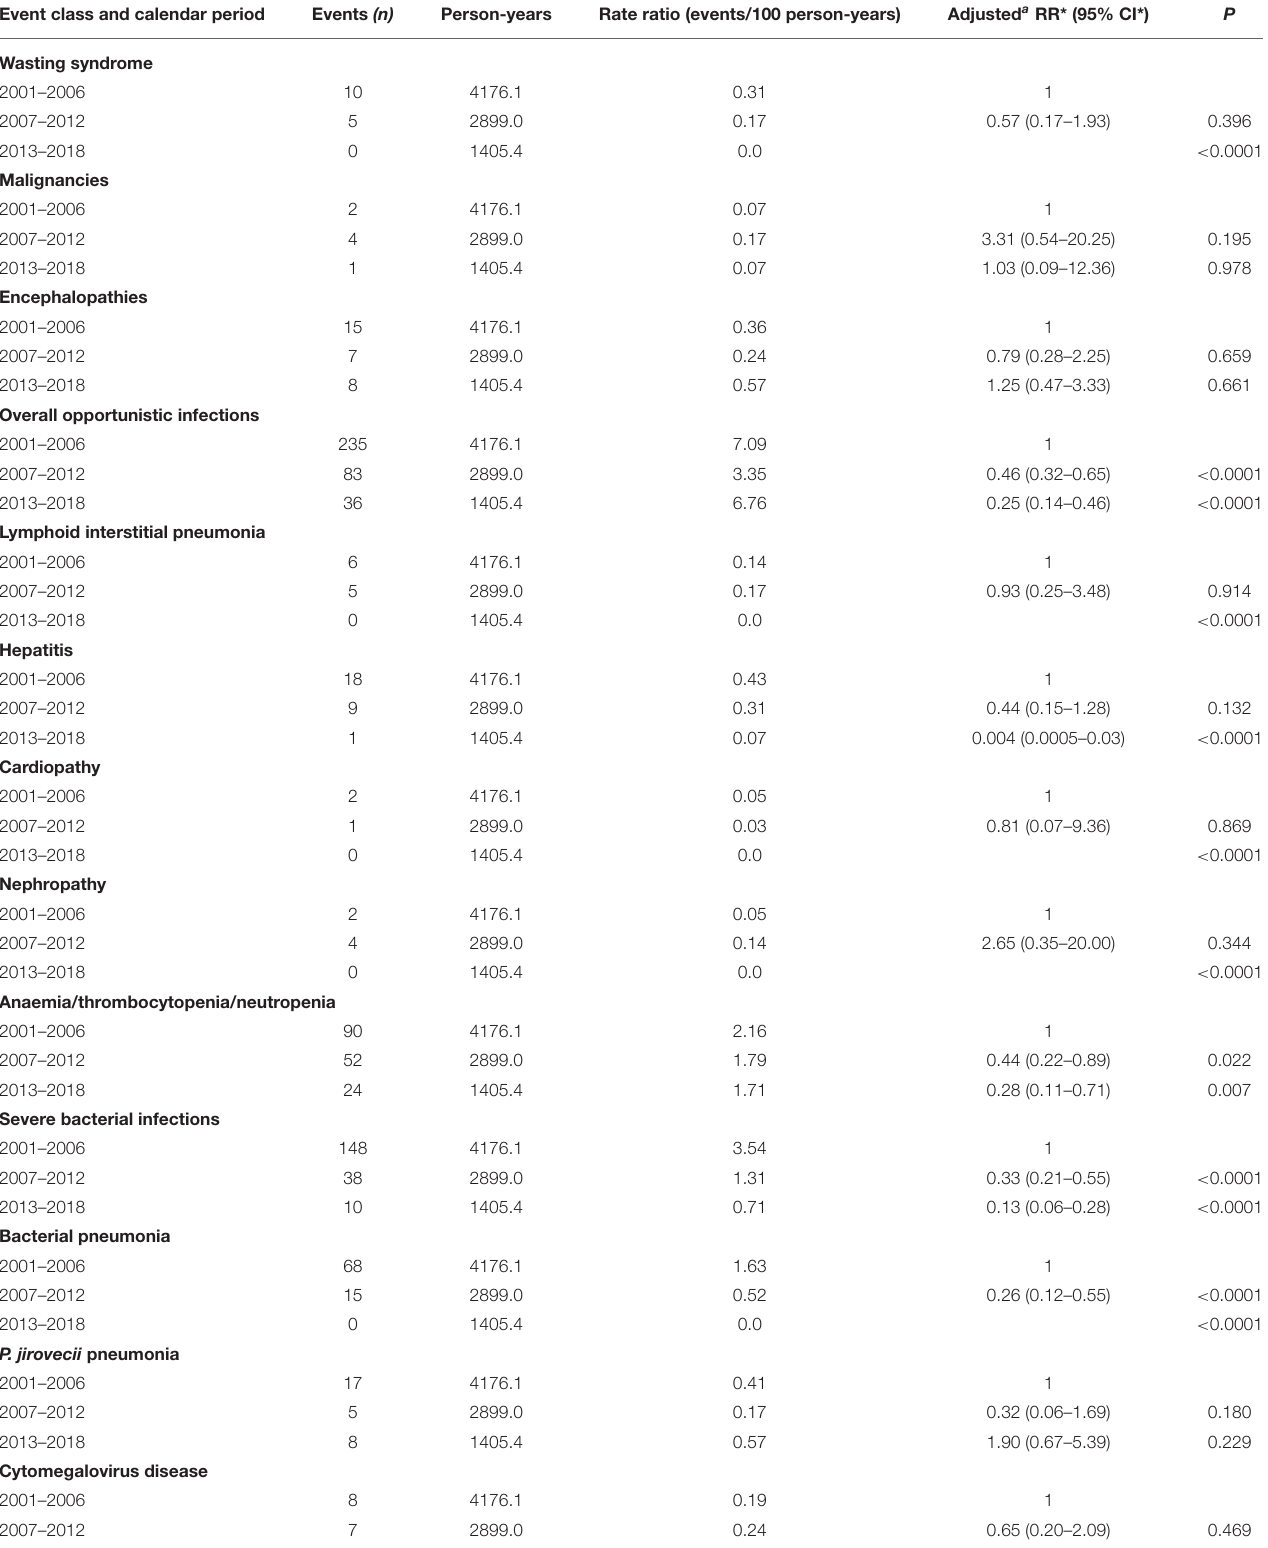
TABLE 6 | Rates of the specific clinical events by calendar period and rate ratio (adjusted for age and repeated events in the same patient). Event class and calendar